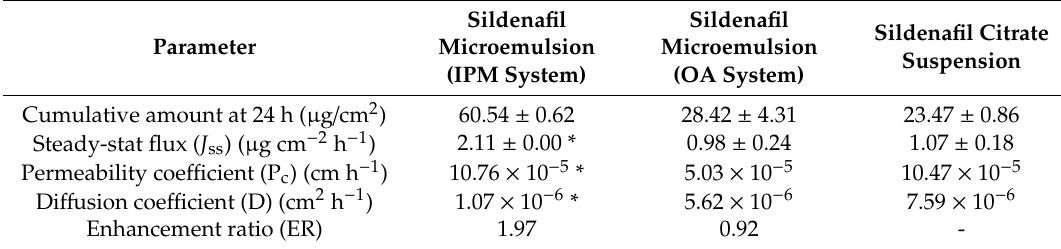
Note: * significant variance ( p -value < 0.05); all values are the mean ± SD, n =